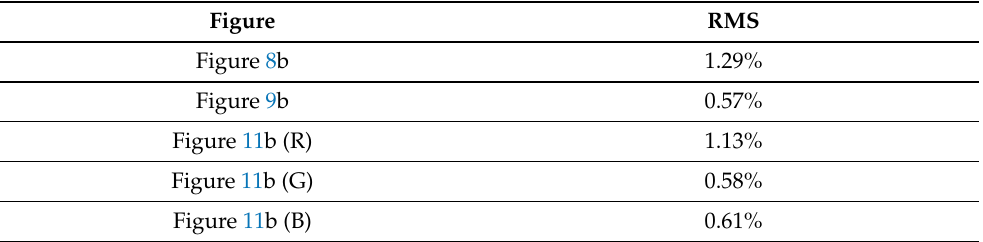
Table 6. Calculated RMS of the stored images, referred to the original image. The results for the color image show the three color planes